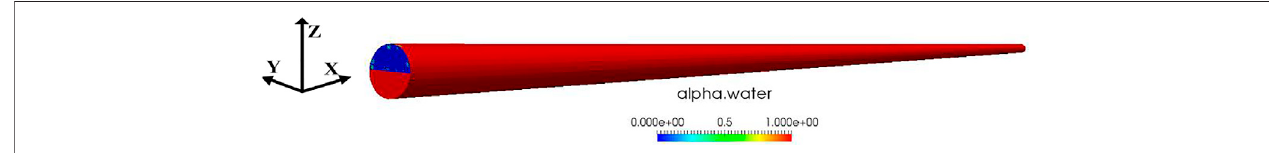
FIGURE 2 | Geometric model of 3D horizontal pipe.